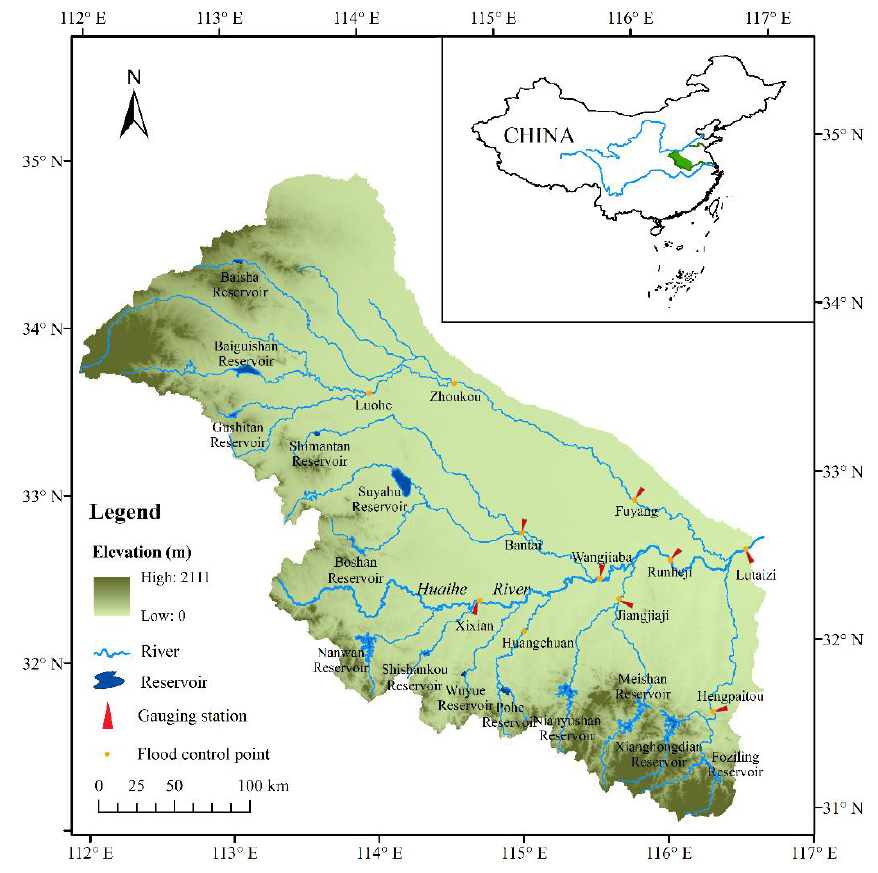
Figure 3. The flood control system in upstream of Lutaizi point of Huaihe River basin.